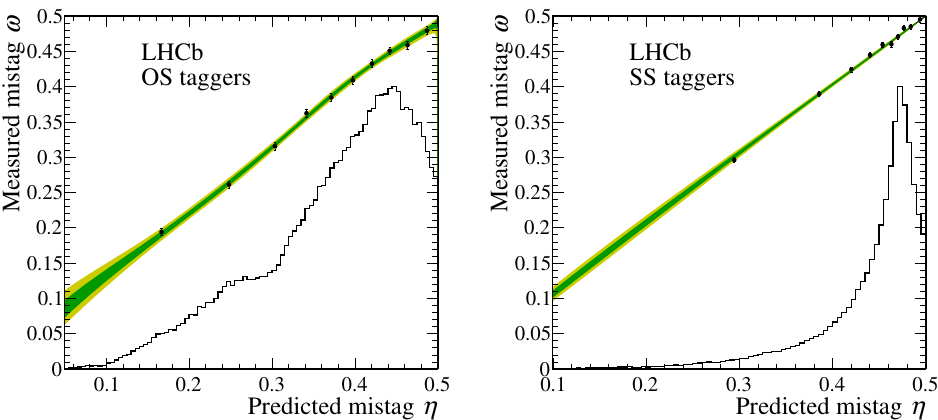
Figure 2 . Measured mistag fraction ! versus predicted mistag probability (cid:17) of the combination of (left) OS and (right) SS taggers as determined in signal decays with the (cid:12)t described in section 6. The black histograms are the distributions of the mistag probabilities in arbitrary units. The shaded areas correspond to the 68% and 95% con(cid:12)dence-level regions of the calibration functions and do not include systematic uncertainties on the parameters. The calibration functions and the distributions of mistag probabilities are shown summing over candidates tagged as either B 0 or B 0